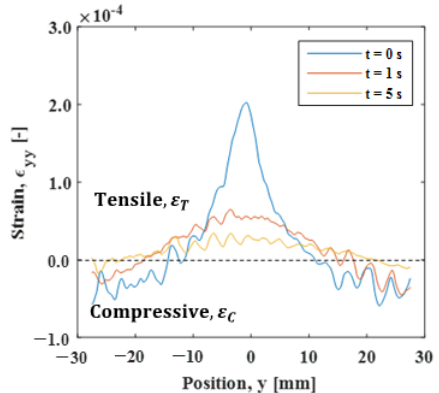
Figure 20. Strain distribution in the y -direction.